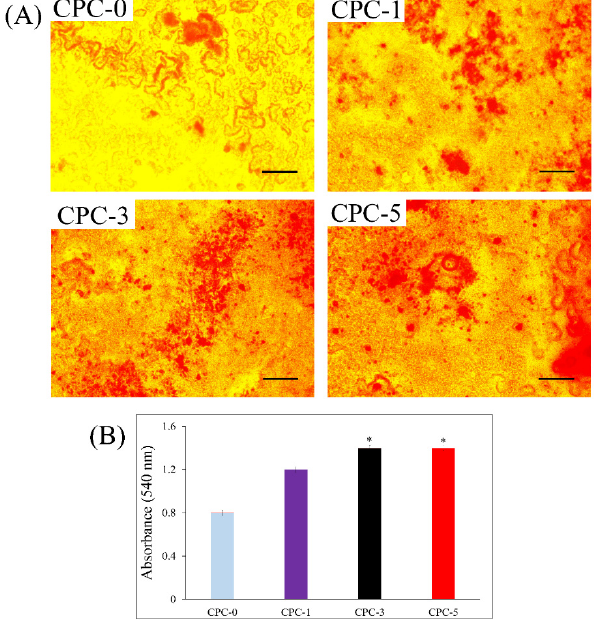
Figure 7. ( A ) Alizarin Red staining of MC3T3-E1 seeded on cement samples on day 14. The scale bar is 200 µm; ( B ) quantitative evaluation of the mineral deposition of the calcium content of MC3T3-E1 cultured on CPCs (* p < 0.05).